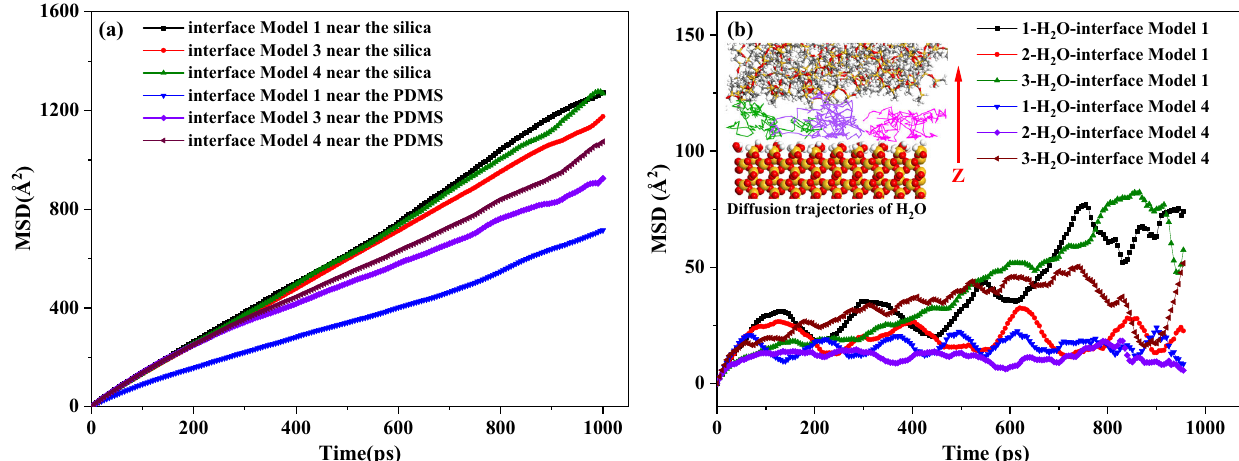
Fig. 13 MSDs of H 2 O molecules in the different silica-PDMS interfaces. a Near the silica and PDMS, and b along the Z-direction.